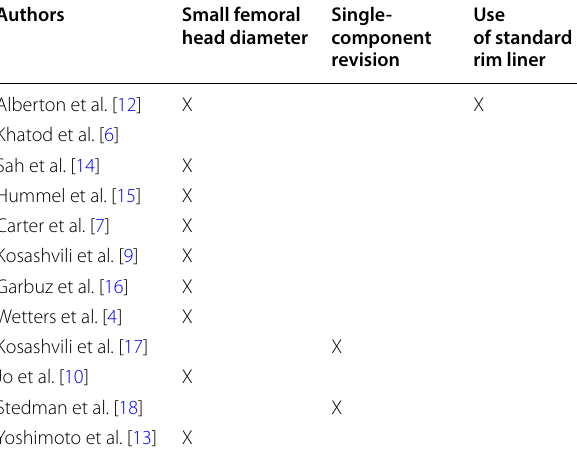
Table 2 Procedure-related risk factors